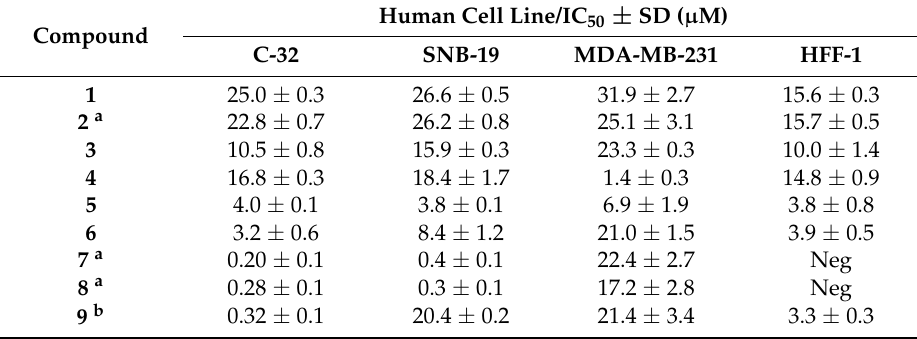
Table 1. The antiproliferative activity of Compounds 1 – 21 and cisplatin as a reference compound. Compound